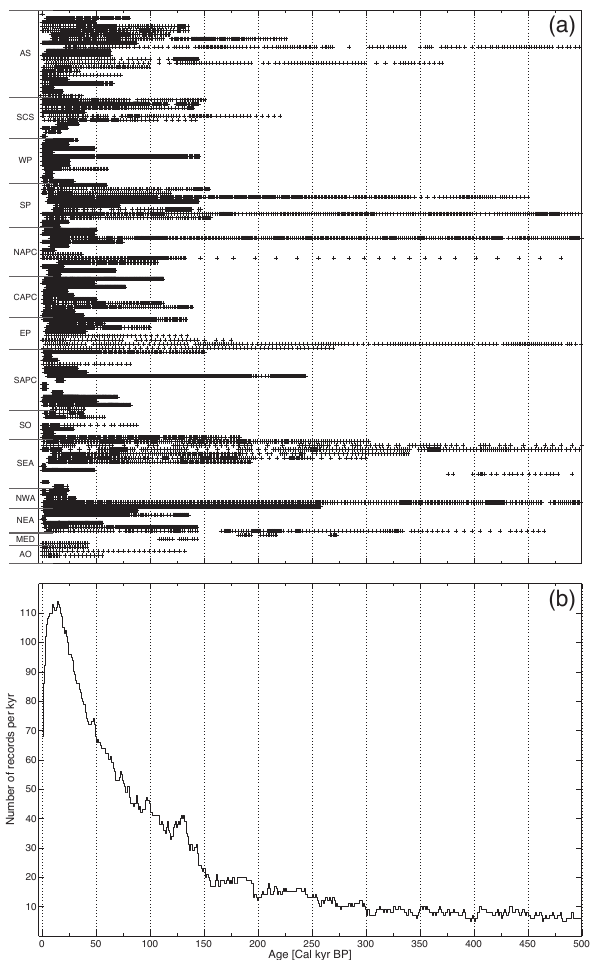
Fig. 4. Data point distribution through the last 500ka. (a) Each record is plotted horizontally, and each black cross represents a data point. Records are grouped by major oceanic regions: Arabian Sea (AS), South China Sea (SCS), west Pacific (WP), subarctic Pacific (SP), North American Pacific coast (NAPC), Central American Pa- cific coast (CAPC), equatorial Pacific (EP), South American Pa- cific coast (SAPC), Southern Ocean (SO), southeast Atlantic (SEA), northwest Atlantic including Caribbean Sea and Gulf of Mexico (NWA), northeast Atlantic (NEA), Mediterranean Sea (MED) and Arctic Ocean (AO). (b) Time series of the number of records perky through the last 500ka.